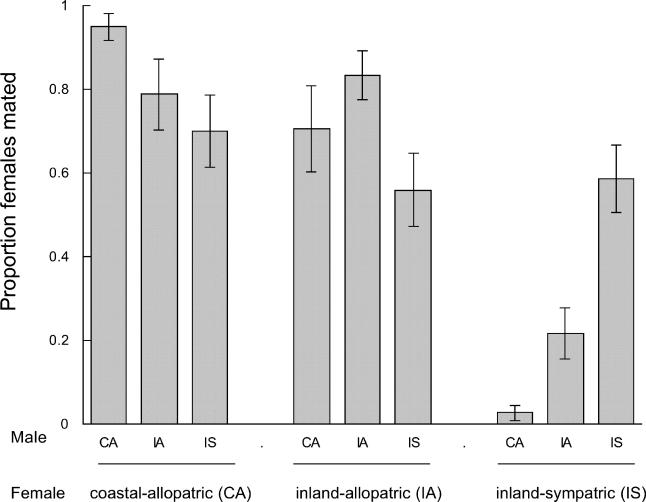
Proportion of D. subquinaria Females from Different Regions That Mated with D. subquinaria Males from These Same Regions in No-Choice TestsCoastal-allopatric (CA), inland-allopatric (IA), or inland-sympatric (IS). Mean ± standard error among the four replicate trials.